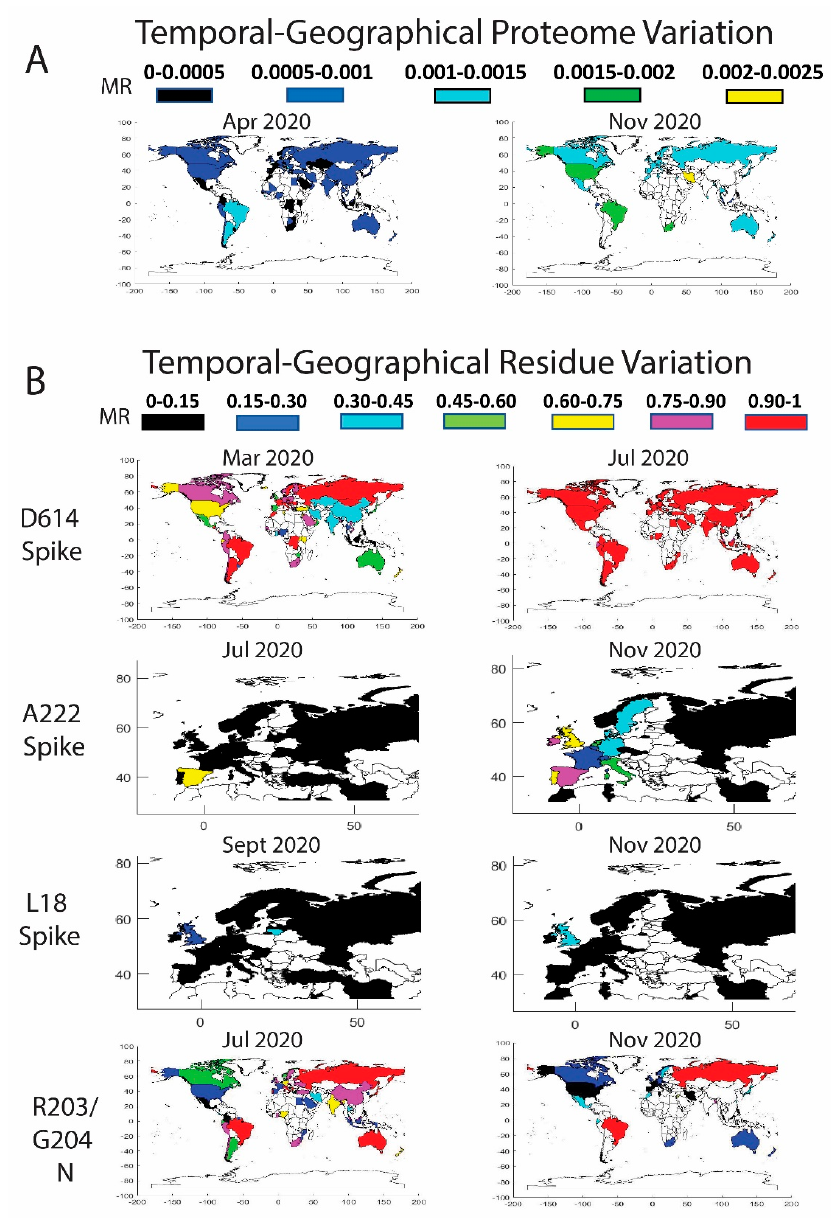
Figure 3. Temporal worldwide mutation rate (MR) analysis for the complete SARS-CoV-2 proteome ( A ) and the high-frequency mutating residues ( B ): D614 in the Spike (correlated data for P323 in the NSP12), A222 in the Spike (correlated data for A220 in the Nucleocapsid and for L67 in the NS9c), L18 in the Spike, and R203/G204 in the Nucleocapsid (correlated data for G50 in the NS9c). A minimum threshold of five sequences was considered in the world plots.